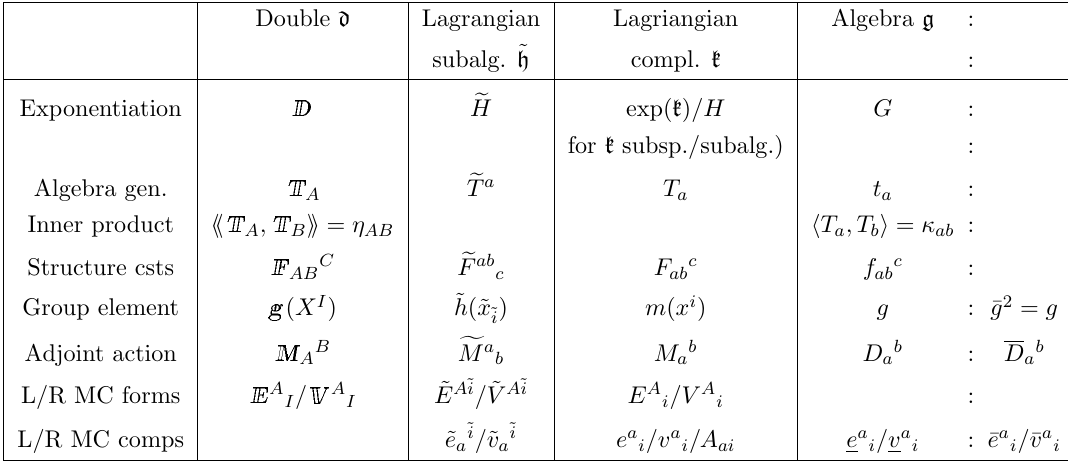
Table 2 . The variety of algebras, groups and group elements used.